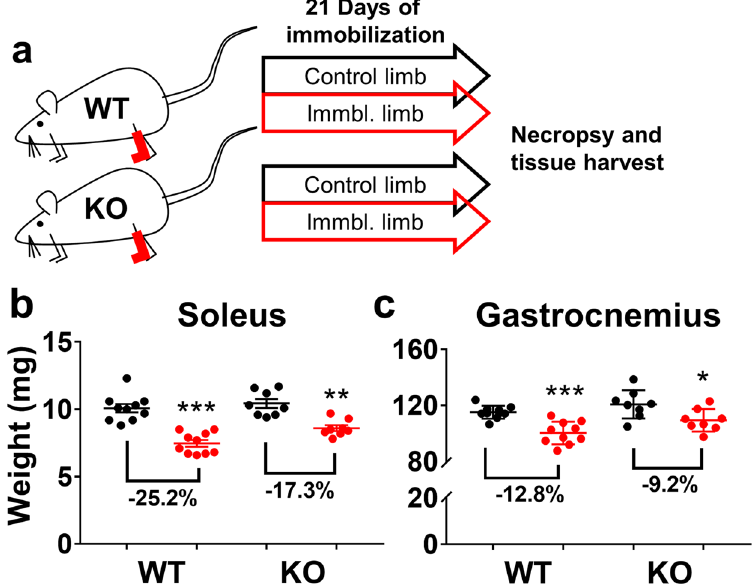
Figure 4. MURF1 deficiency mitigates muscle loss induced by hindlimb immobilization. ( a ) Graphic representation of study design depicting 21 days of unilateral hindlimb immobilization in WT (n = 10) and MuRF1 KO (n = 8) mice. Both WT and MuRF1 KO mice present with significant ( b ) soleus and ( c ) gastrocnemius muscle loss in the immobilized limb (red) relative to control limb (black). Muscle atrophy is mitigated in both muscles by MuRF1 KO. Data are presented as means ± SEM (n = 5/group). * p < 0.05, ** p < 0.01, *** p < 0.001, immobilized vs. contralateral non-immobilized limb by paired t-test. WT, Wild-type; KO,